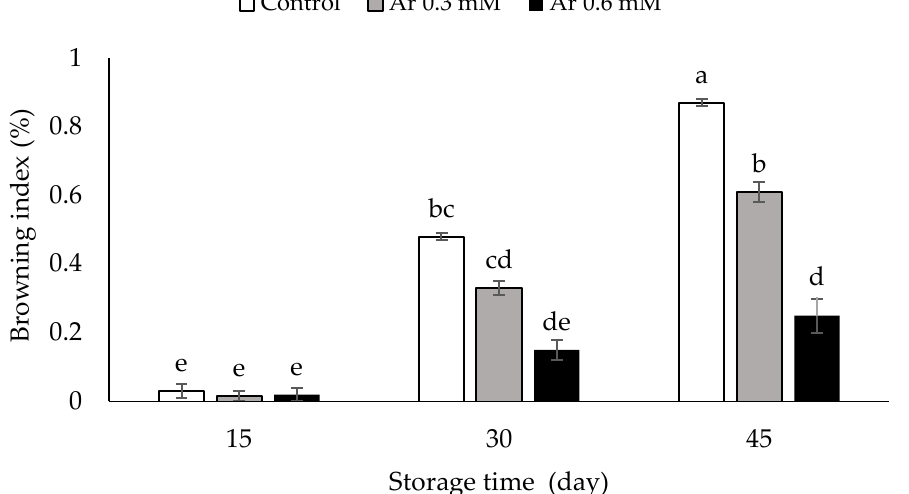
Figure 1. The effect of different levels of postharvest treatment of L-arginine on browning index of persimmon cv. “Karaj” fruits during cold storage (DMRT, p ≤ 0.05). The values of data are average of n = 3, and bar represents standard error of the means. Different letters above the bars show significant difference at p < 0.05 by Duncan’s multiple range test.